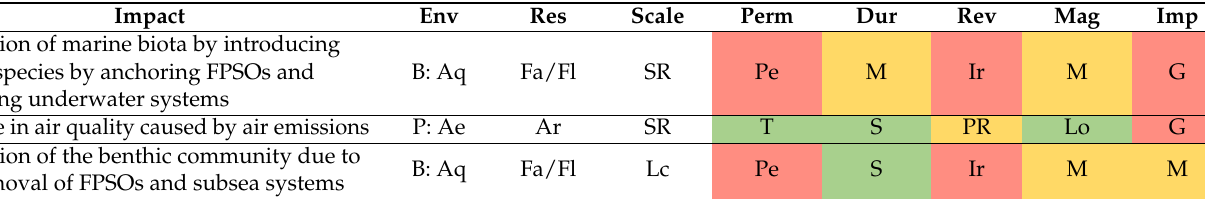
Table 3. Effective Impacts during Stage 1.